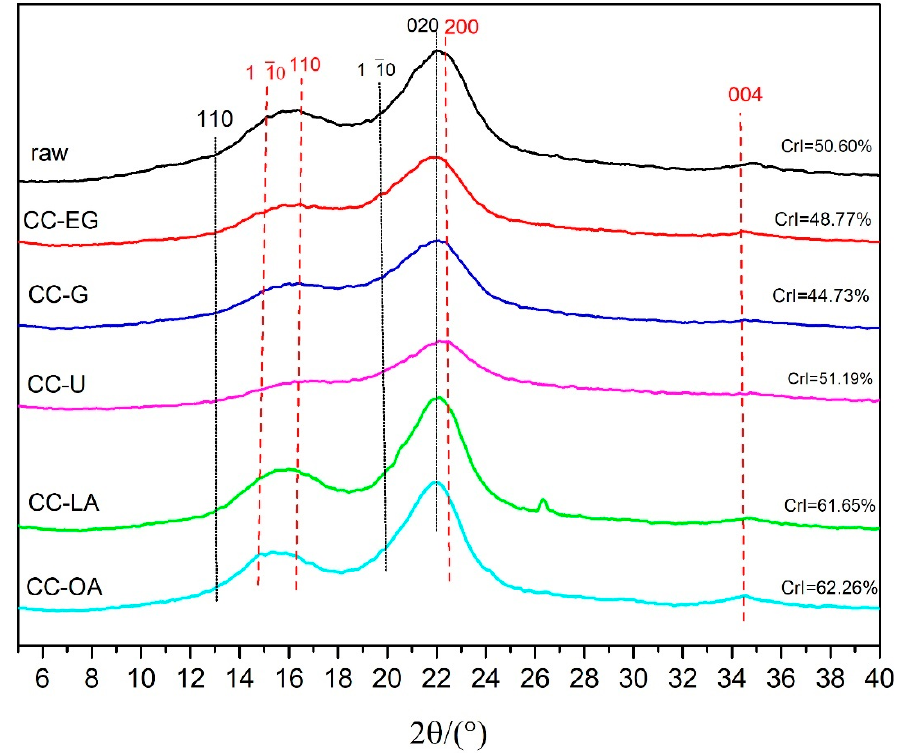
Figure 3. XRD patterns of bagasse cellulose treated with different